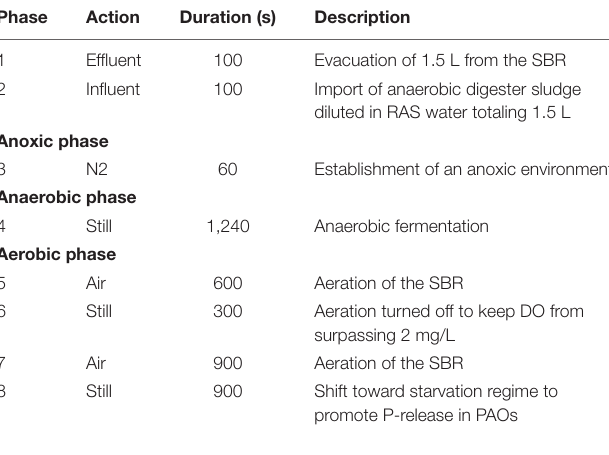
TABLE 1 | Sequential batch reactor (SBR) cycling regime used in this